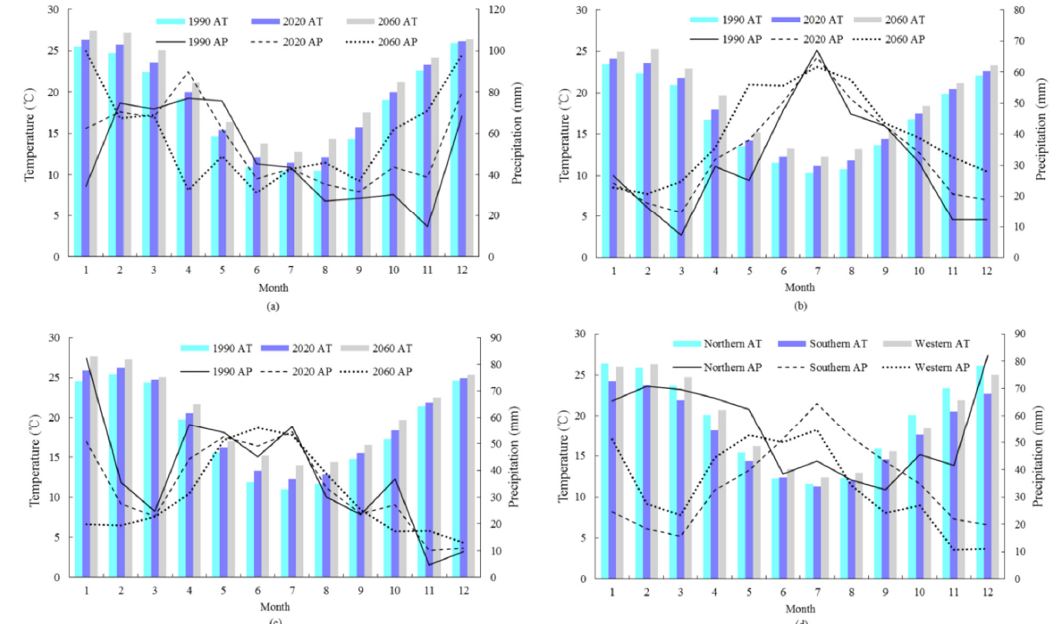
Figure 2. Climate change trends (1990–2060) for the three wheat cropping systems. AT and AP represent monthly average temperature and monthly average precipitation, respectively. ( a ) The northern wheat cropping region, ( b ) the southern wheat cropping region, ( c ) the western wheat cropping region, ( d ) variation in temperature and precipitation (1990–2060) for the three wheat cropping regions.